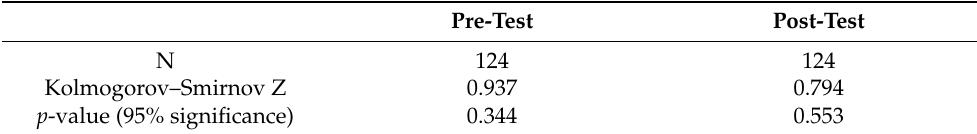
Table 4. One-sample table: Kolmogorov–Smirnov test to pre- and post datasets.